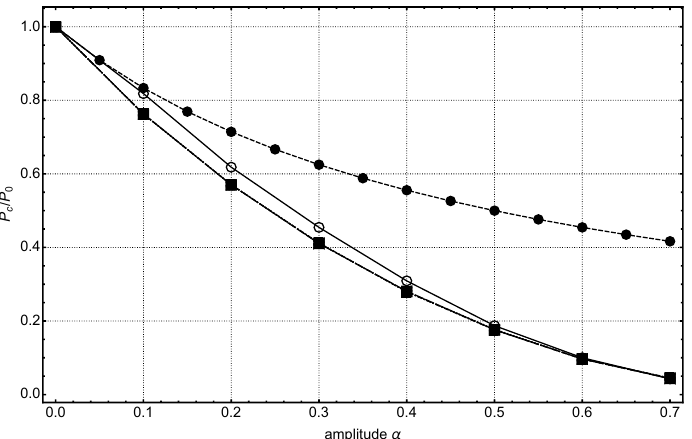
Figure 8. Critical buckling load as it depends on the amplitude of corrugations or the neck size. The full line with open circles is the result of the corrugated beam, see Equation (27). The dashed line with the full circles is the analytical result of the linear Euler theory, see Equation (25) and the long-dashed line with the full squares presents the result of the FEM calculations of a string of pearls with concave necks. This curve is also the result for three different particle radii. They all coalesce and thus only the value of α is